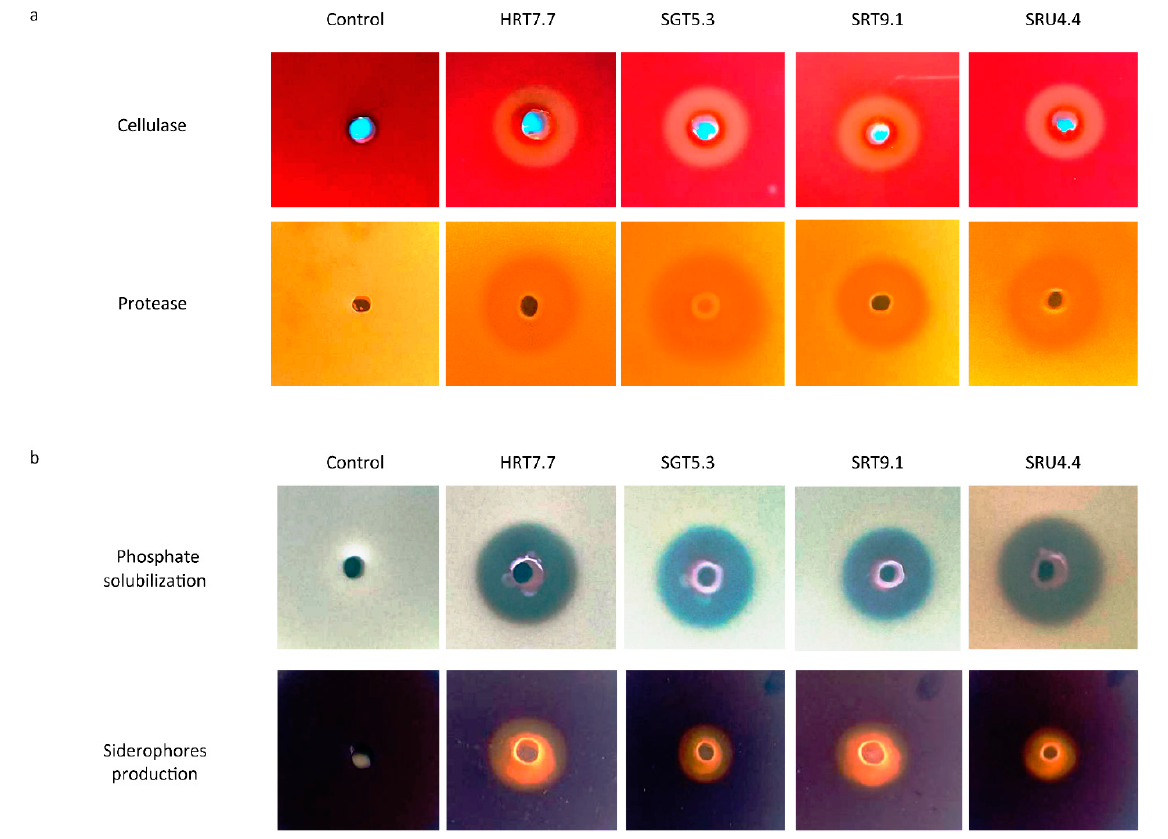
Figure 4. Production of antimicrobial traits by Bacillus cereus (HRT7.7), Paenibacillus polymyxa (SRT9.1), Serratia marcescens (SGT5.3), and Enterobacter hormaechei (SRU4.4). ( a ) Production of cellulase and protease, ( b ) phosphate solubilization, and siderophore